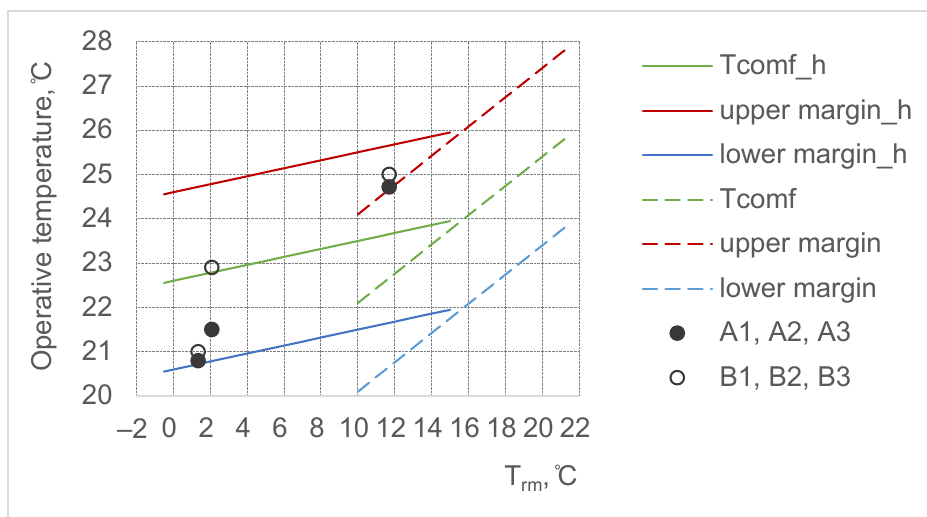
Figure 4. Relationship between weighted mean running outdoor temperature (T rm ) and operative temperature (T o ) in the investigated room. Continuous lines are dedicated for heating mode, dashed—for free-running buildings. Green lines indicate the comfort temperature, where the red and blue line define the upper and lower limit of comfort temperatures, respectively. Black and white dots represent the room operating temperatures during the 3 days of the survey .